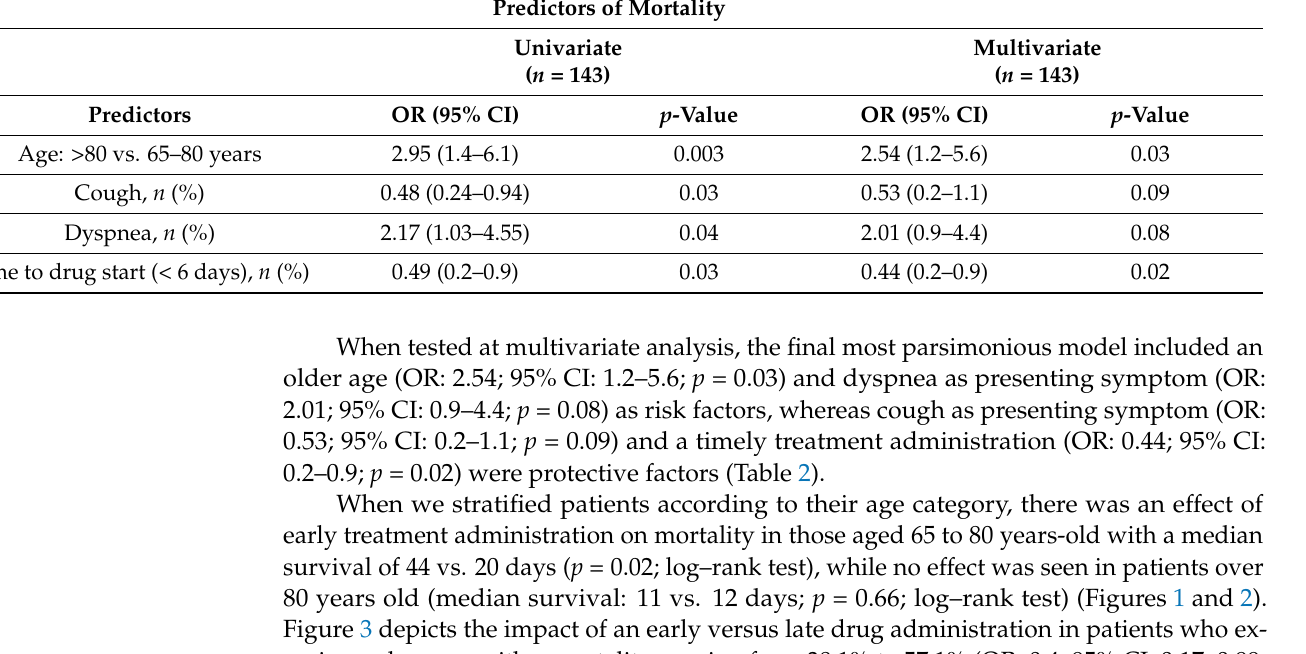
Predictors of Mortality Univariate ( n = 143)